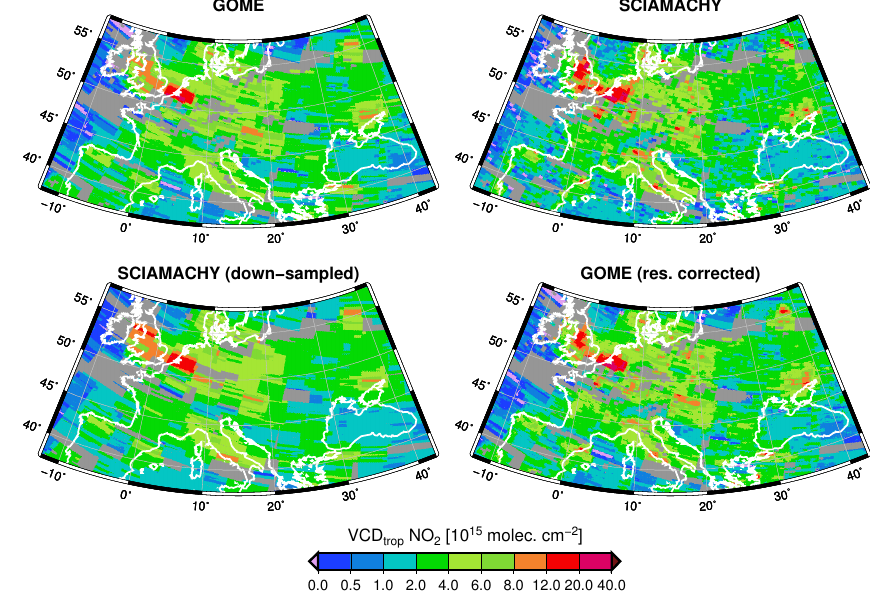
Fig. 7. Tropospheric NO 2 columns from GOME (top left), SCIAMACHY (top right), down-sampled SCIAMACHY (bottom left), and resolution-corrected GOME (bottom right) measurements for May 2003, gridded to 1 / 16 ◦ × 1 / 16 ◦ . The effect of spatial smoothing can be seen in the original GOME and the down-sampled SCIAMACHY measurements for all point-like sources like cities, as the signal becomes smeared out.